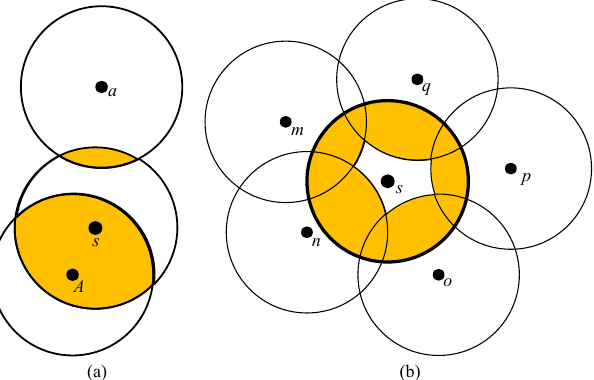
Figure 8. ( a ) For s , the area covered by its R NBs (i.e., A ) is larger than that of its R − 2 R NBs (i.e., a ); ( b ) The coverage degree of s is 1, if s has only R − 2 R NBs